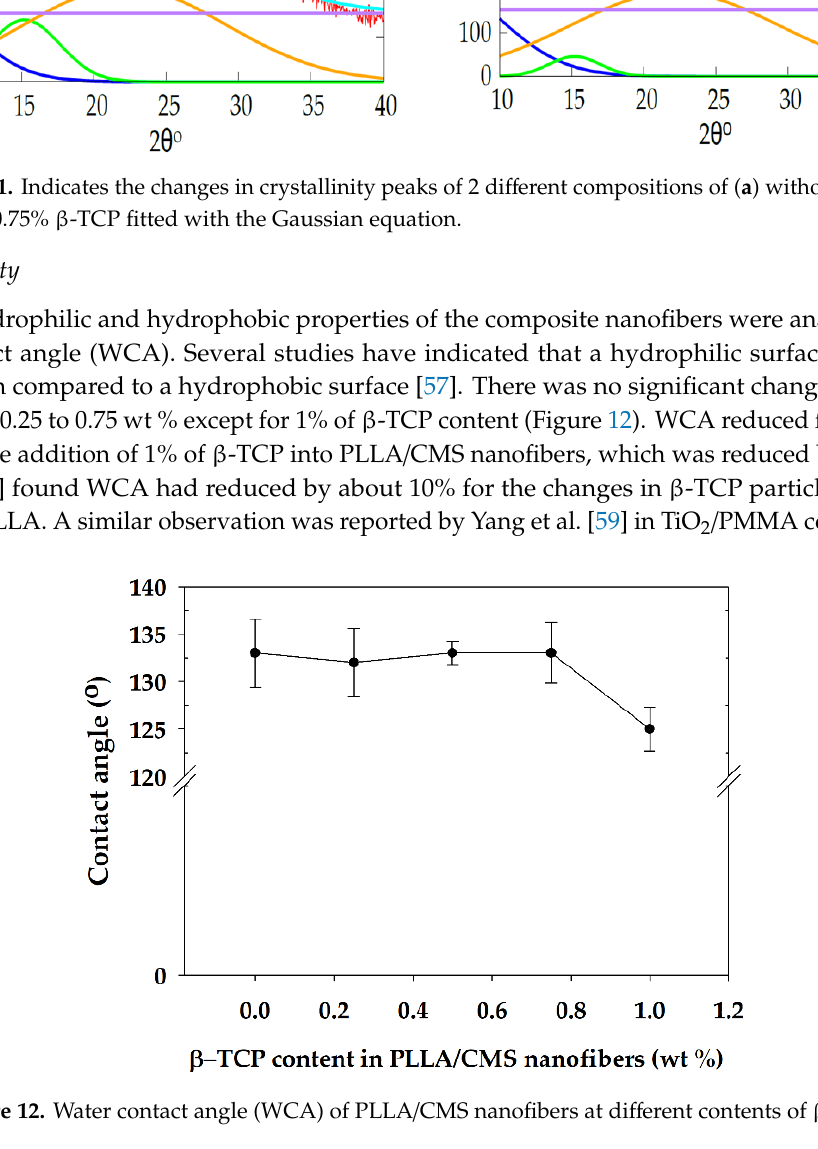
Figure 11. Indicates the changes in crystallinity peaks of 2 different compositions of ( a ) without β - TCP and ( b ) 0.75% β -TCP fitted with the Gaussian equation.